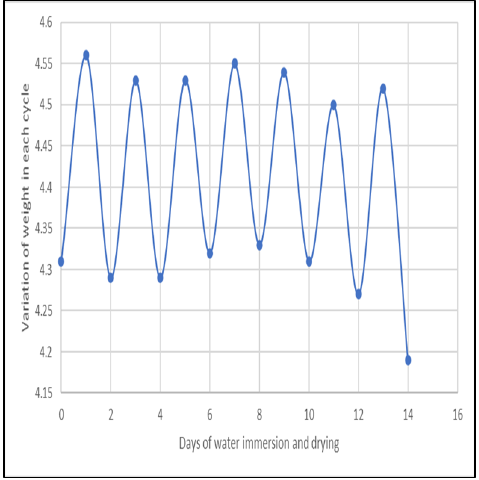
Figure 22. Alternate wetting and drying test of sustainable red mud bricks.